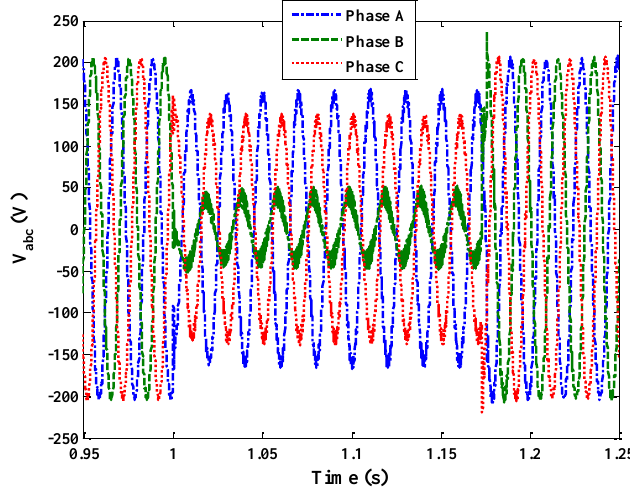
Figure 15. Three-phase voltages of the PV generation system under the asymmetrical fault.